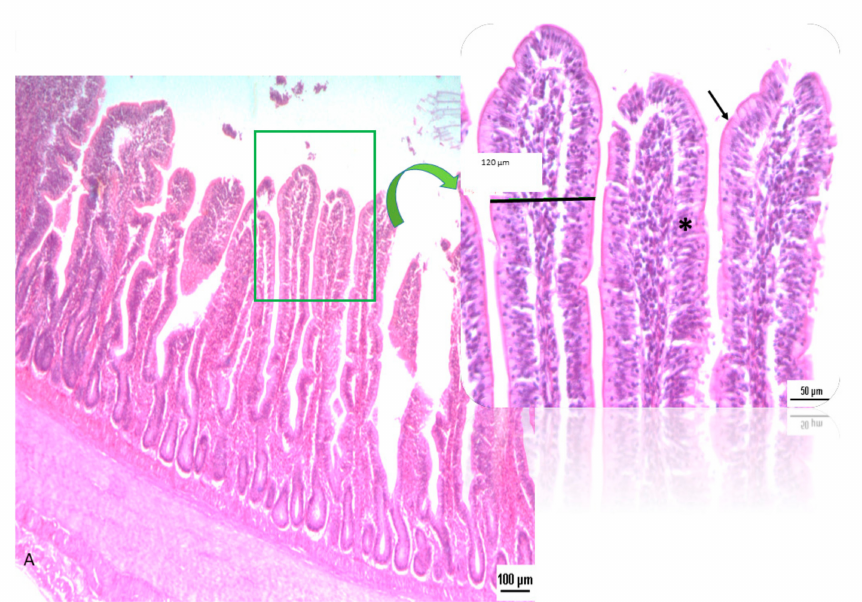
Figure 1. Histological section of OA&EO chicken gut. OA&EO intestinal tract, where villi were slim and finger-shaped. Each villus is lined by columnar epithelial cells with a nucleus positioned at the basal third of the cell (*); at the apex there are microvilli (arrow) that increase the absorbent surface (H&E 5 × , 20 × magnification).